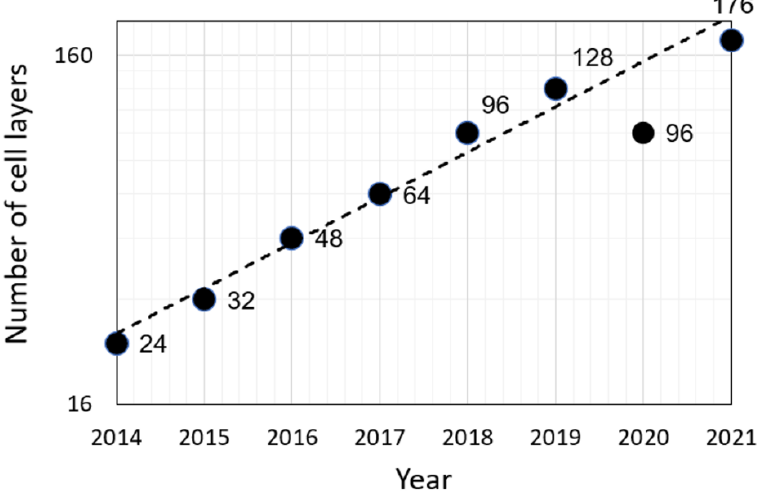
Figure 10. The year-by-year trend of cell layer stacking in 3D NAND published in ISSCC conferences.